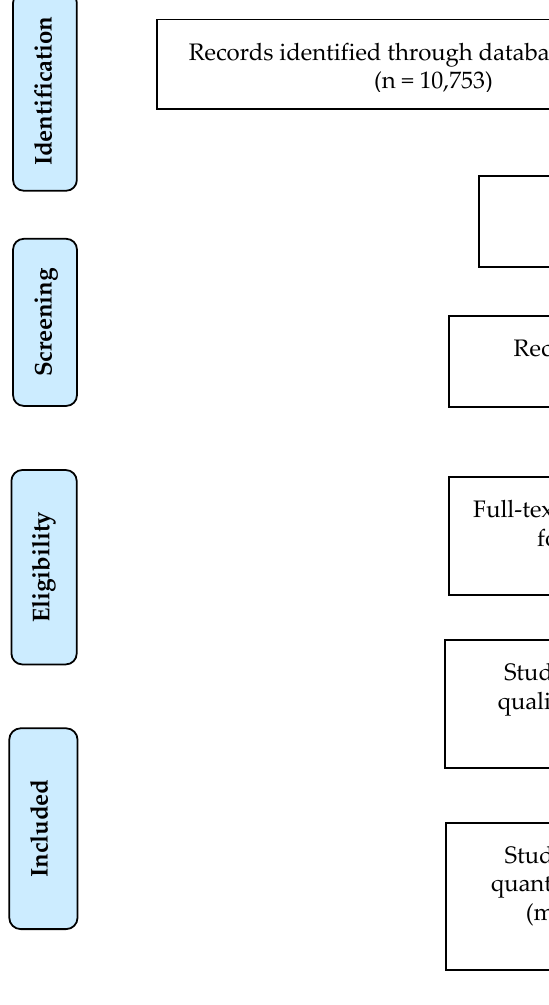
Figure A1. Study selection flow diagram.